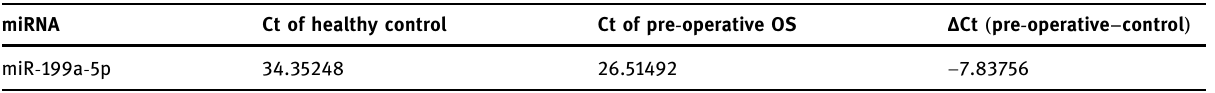
Table 1: miR - 199a - 5p Ct of control and pre - operative OS miRNA Ct of healthy